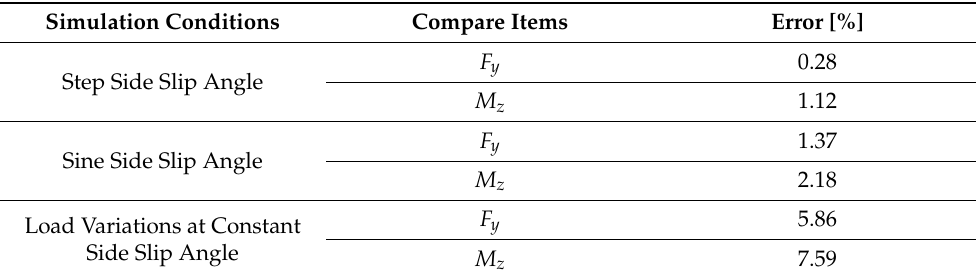
Table 4. The simulation errors at pure side slip